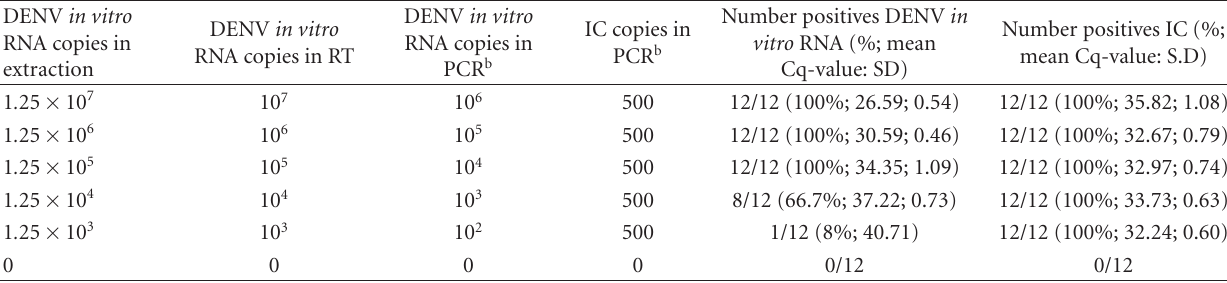
Table 3: Dynamic range of generic real-time PCR a .